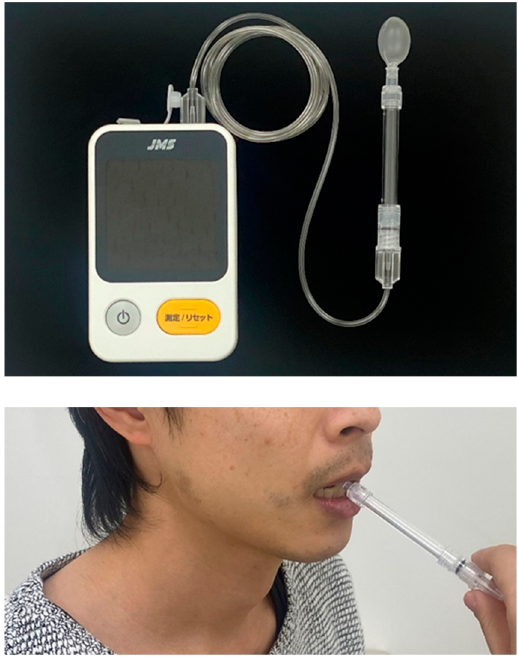
Figure 2. JMS tongue pressure measurement device ( top ), and measurements of tongue pressure ( bottom